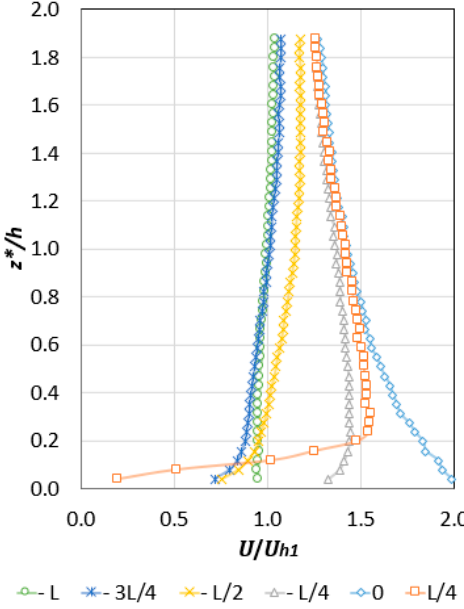
Fluids 2019 , 4 , x Figure 6. Configuration A: Vertical wind speed profiles at locations 1 to 6. Figure 6. Configuration A: Vertical wind speed profiles at locations 1 to 6.